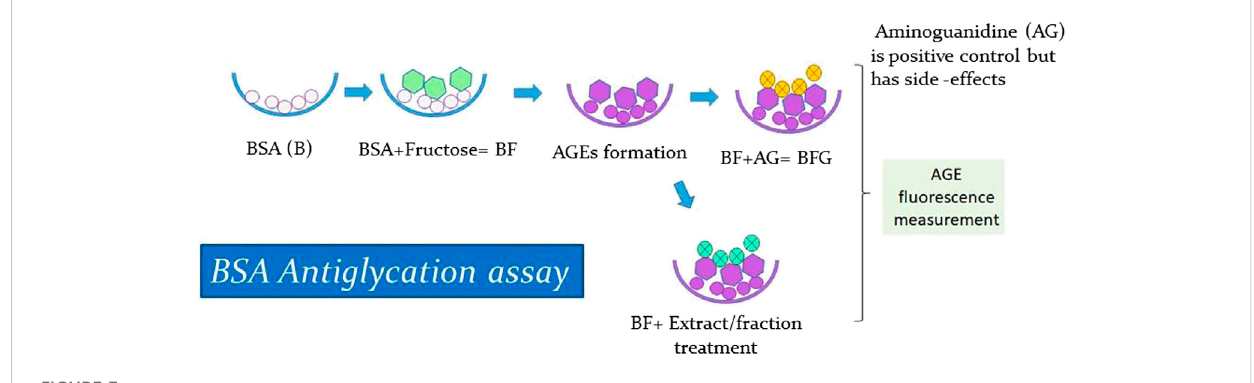
FIGURE 3 Antiglycation Assay.